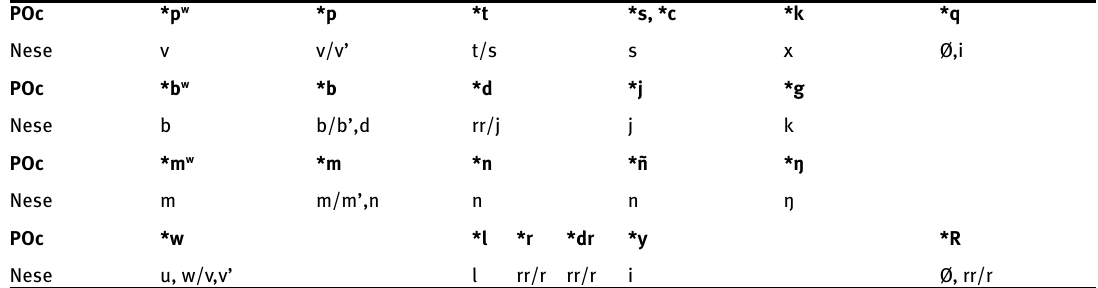
Table 2: Nese reflexes of POc